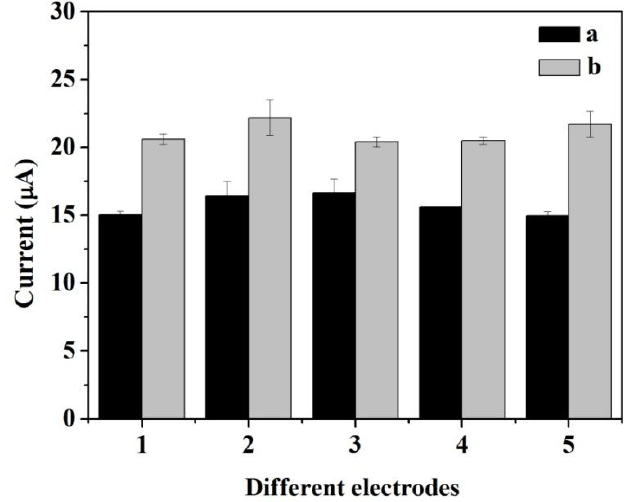
Figure 9. The repeatability and the reproducibility of the response of ( a ) CNFs/Lac/Nafion/GCE and ( b ) Cu/CNFs/Lac/Nafion/GCE. Conditions: scan rate 100 mV/s, pH 5.5 (a), pH 6.0 (b). The error bars indicate the standard error for three measurements with the same electrode.